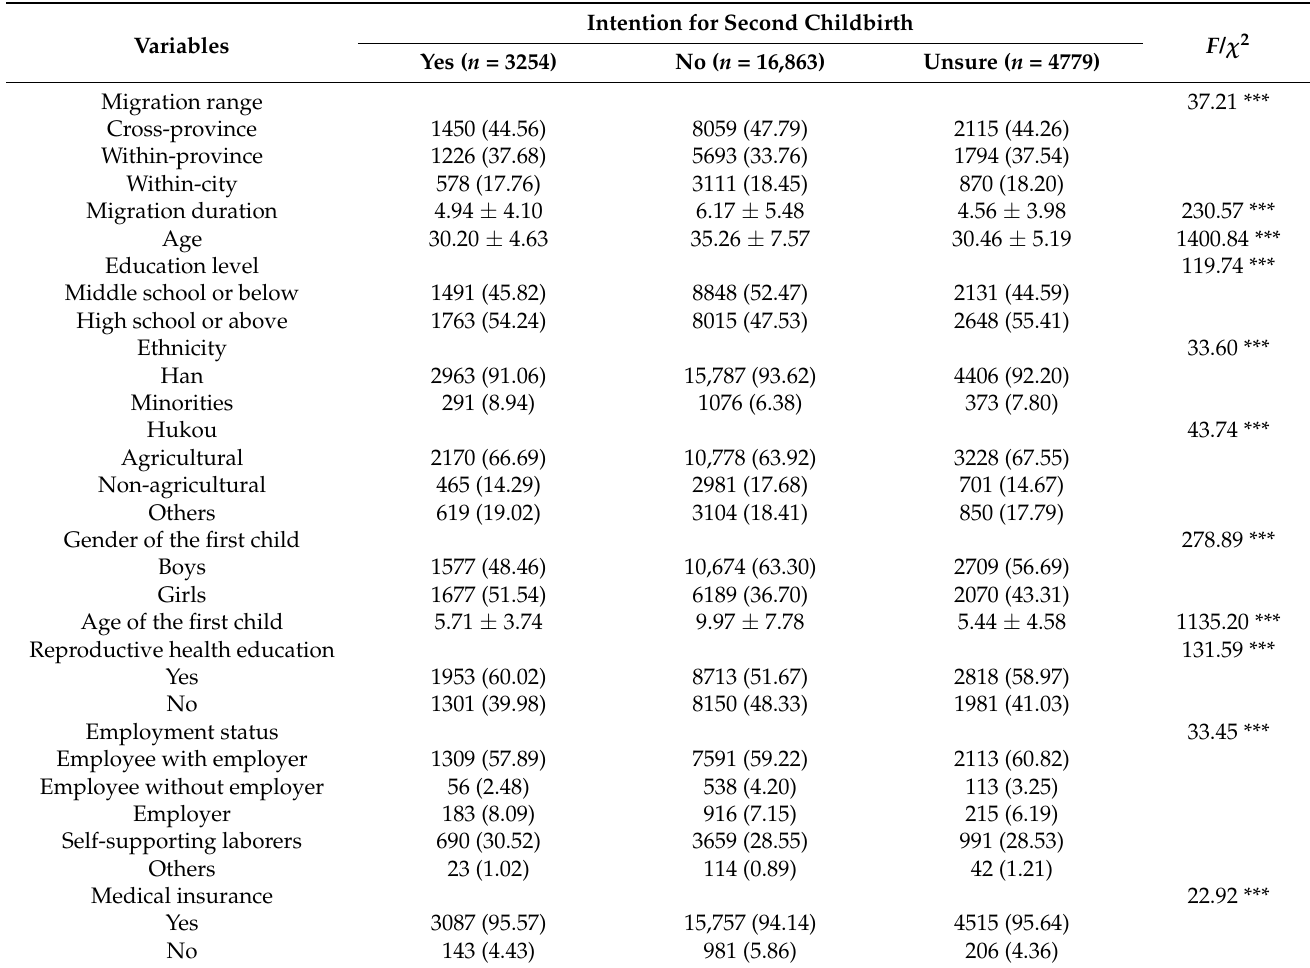
Table 2. Fertility intention to have a second child among participants.